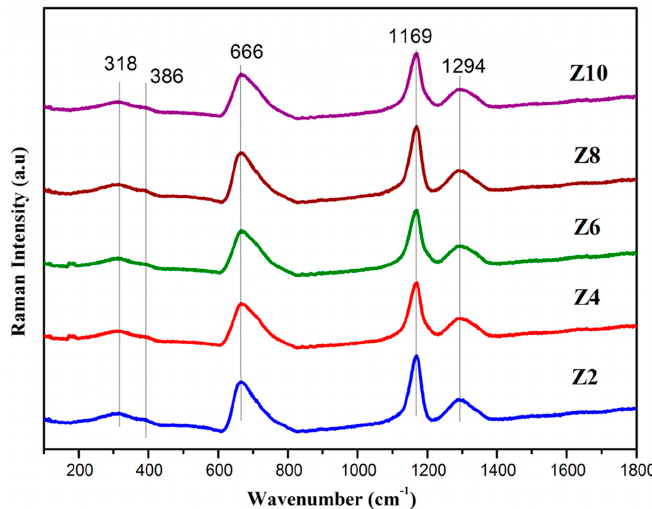
Figure 8. Raman spectra of Z2, Z4, Z6, Z8 and Z10 glasses at room temperature. J. Compos. Sci. 2020 , 4 , x